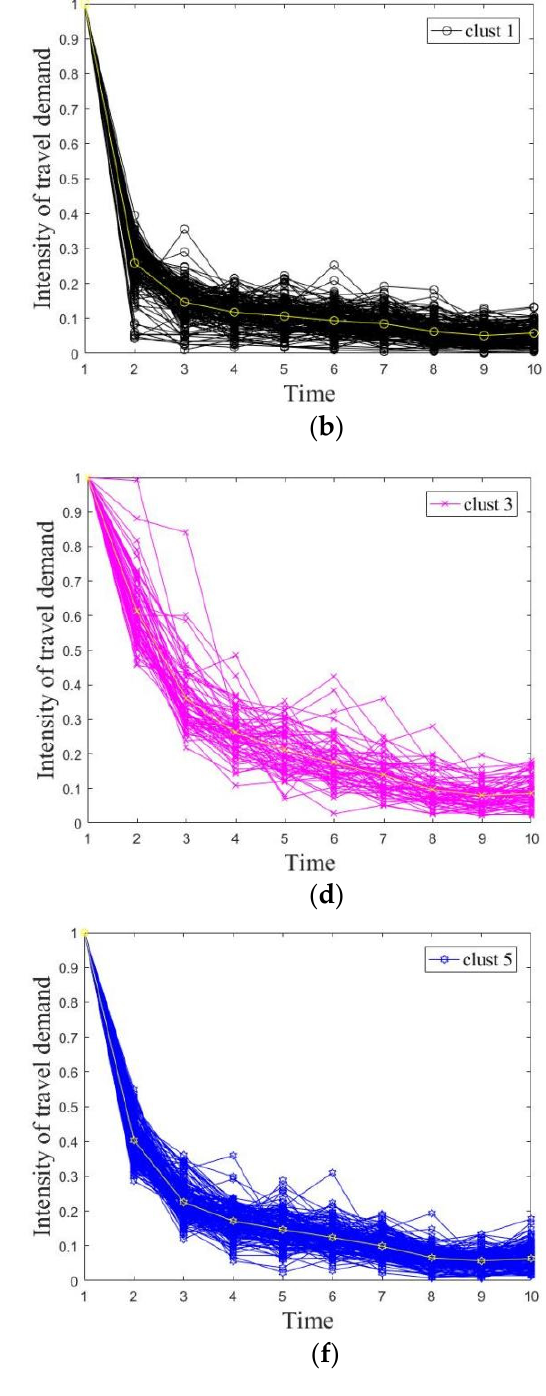
Table 3. Taxi travel demand balance table for various types of blocks.